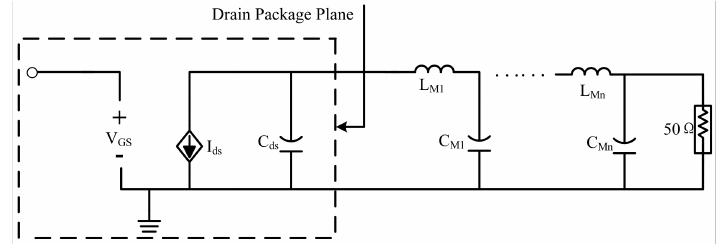
Figure 1. Transistor equivalent model and output equivalent circuit [13].